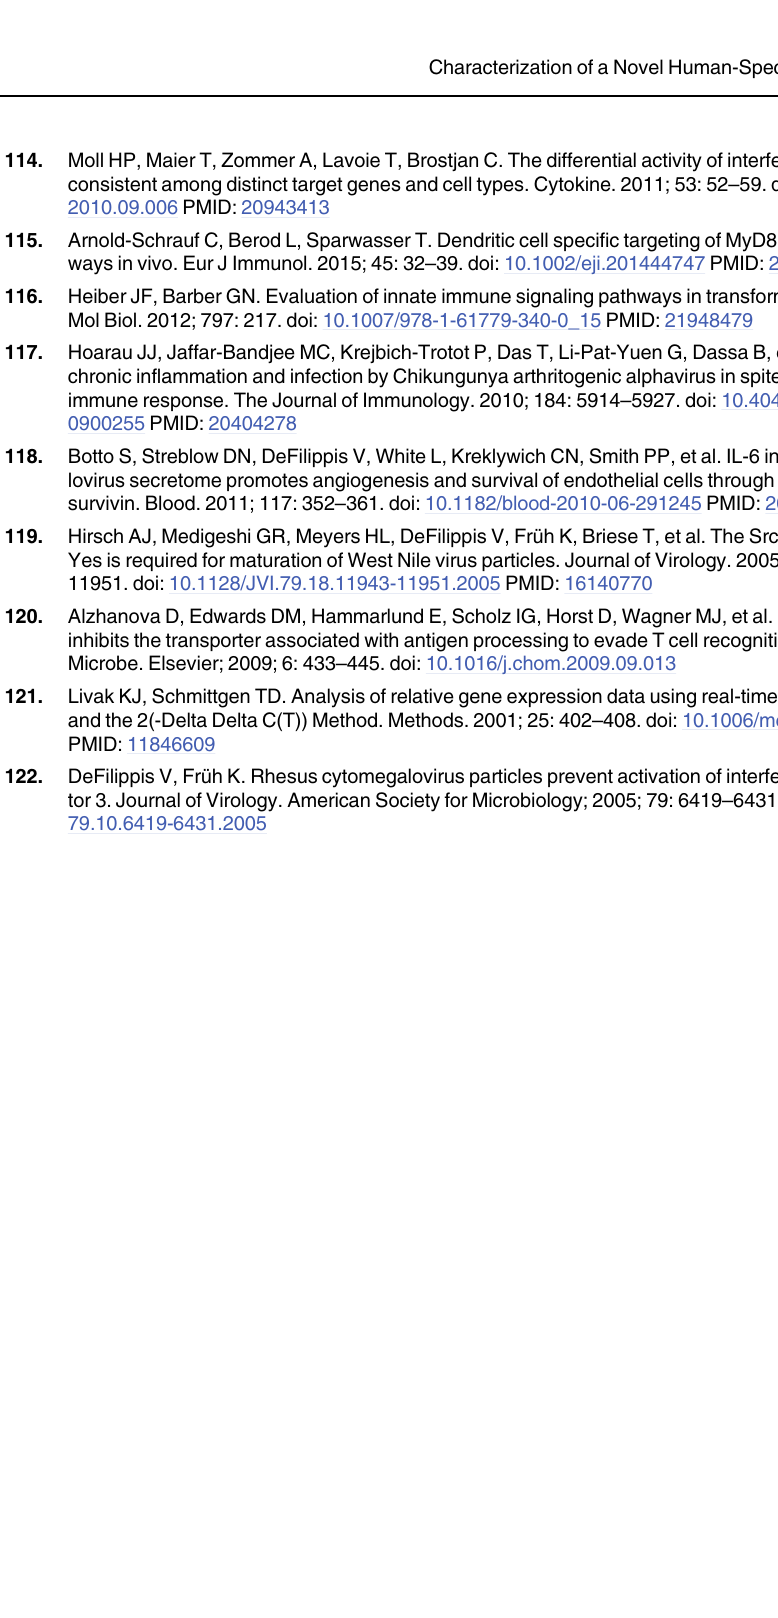
PLOS Pathogens | DOI:10.1371/journal.ppat.1005324 December 8,